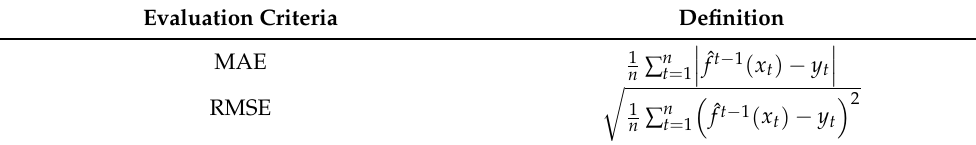
Table 2. Table of evaluation